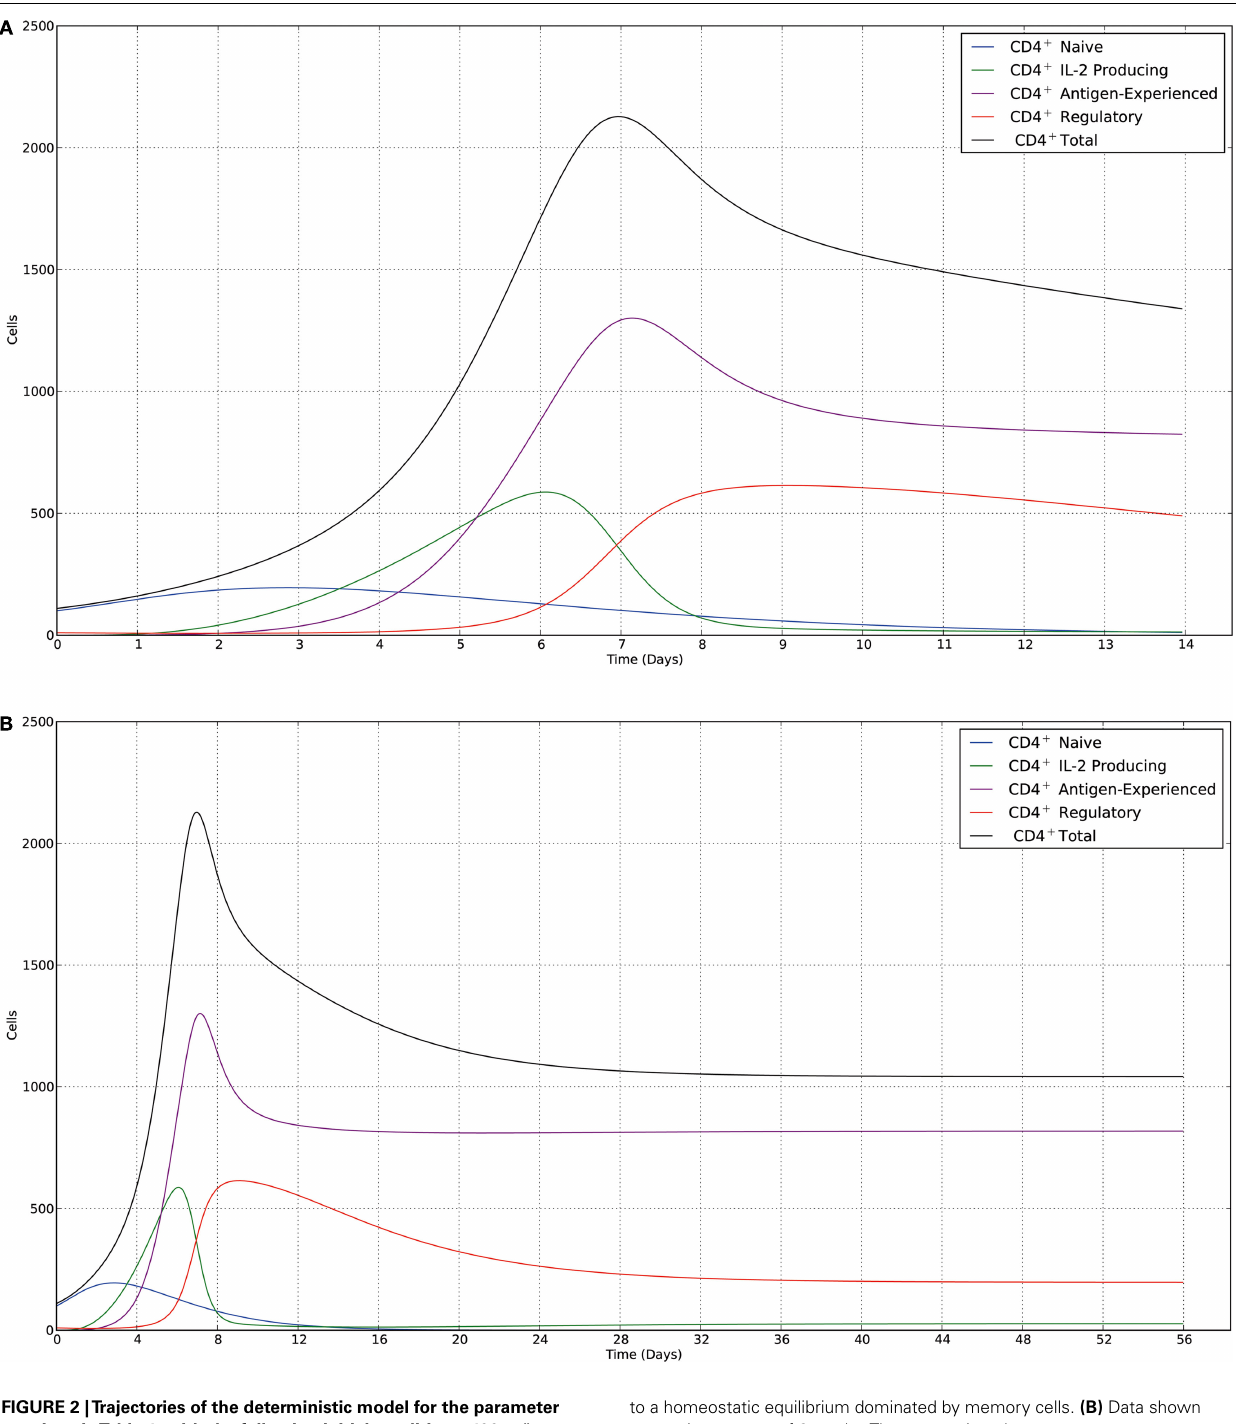
to a homeostatic equilibrium dominated by memory cells. (B) Data shown over a time course of 8weeks.The contraction phase occurs over an extended time period of ∼ 20days for memory cells and ∼ 40days for regulatory cells.